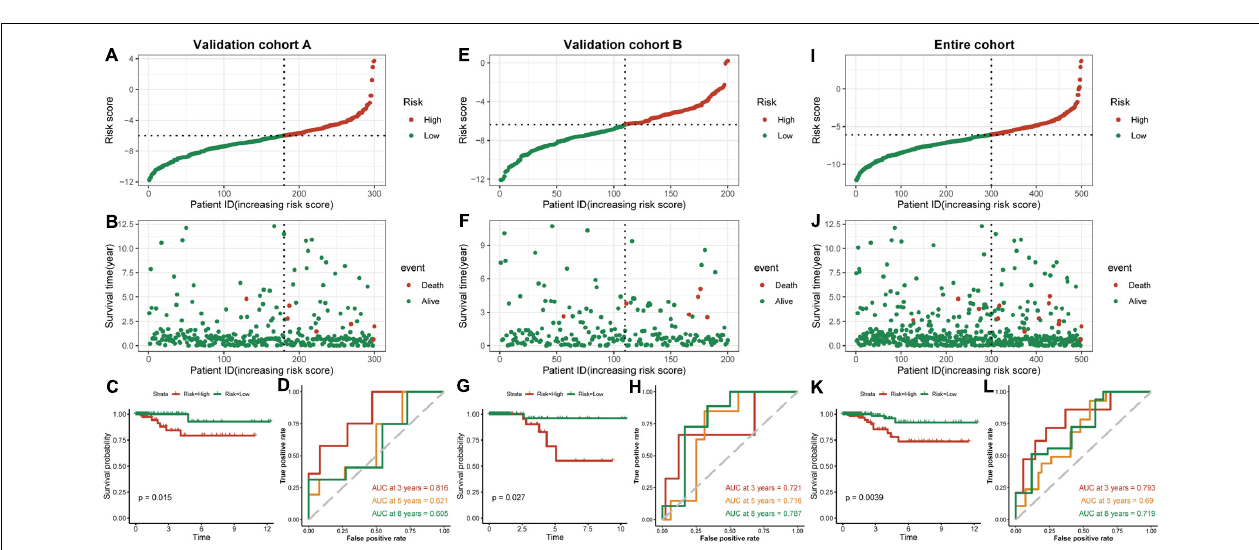
FIGURE 5 | The relationship between the hub genes and TNM. (A) T stage. (B) Lymph node status. (C) Metastasis.